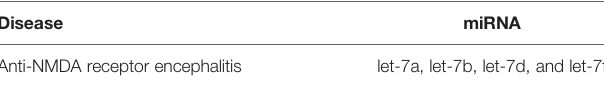
TABLE 3 | miRNA biomarkers related to anti-NMDA receptor encephalitis (41). Disease